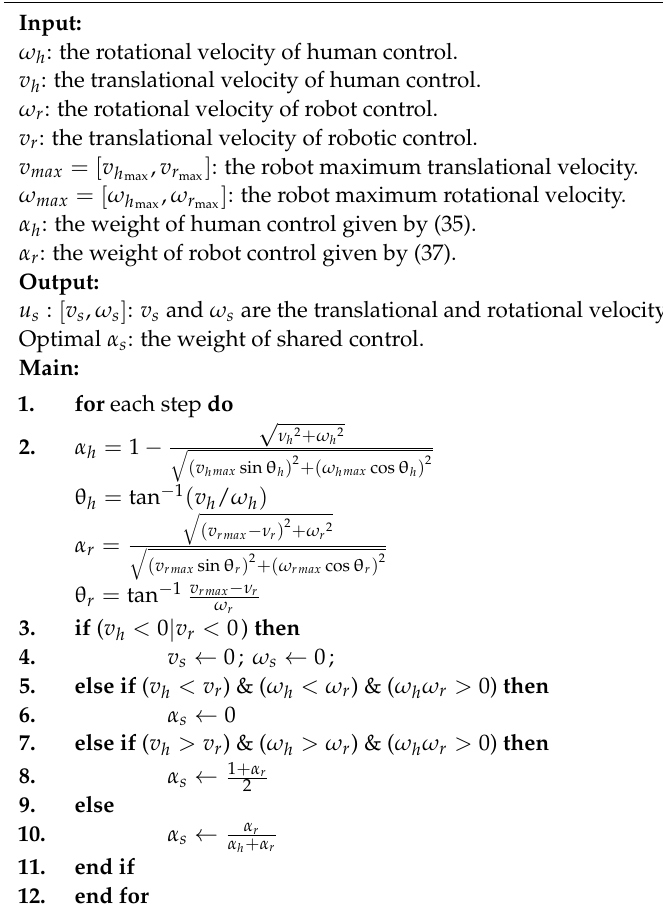
Figure 6. Illustrations of the determination of control weight of human user and robot inputs. ( a ) Control weight of human user input. ( b ) Control weight of the robot input. Algorithm 1 shows the pseudo-code of the proposed algorithm for deriving the weights adaptation. Steps 3 to 11 present the auto-tuning scheme for the weight α s , where the dichotomy method is used when the valid input set from the robot is included in the one from the user. As for the case when an unstable condition happens, the shared weight yielded to take the input set from the robot more than the one from the user into account. Note that since there is no sensor in the back of the wheeled chair, our system currently is only allowed to move forward, stop, or turn either left or right. Algorithm 1: Weight adaptation for the Human and the Robot